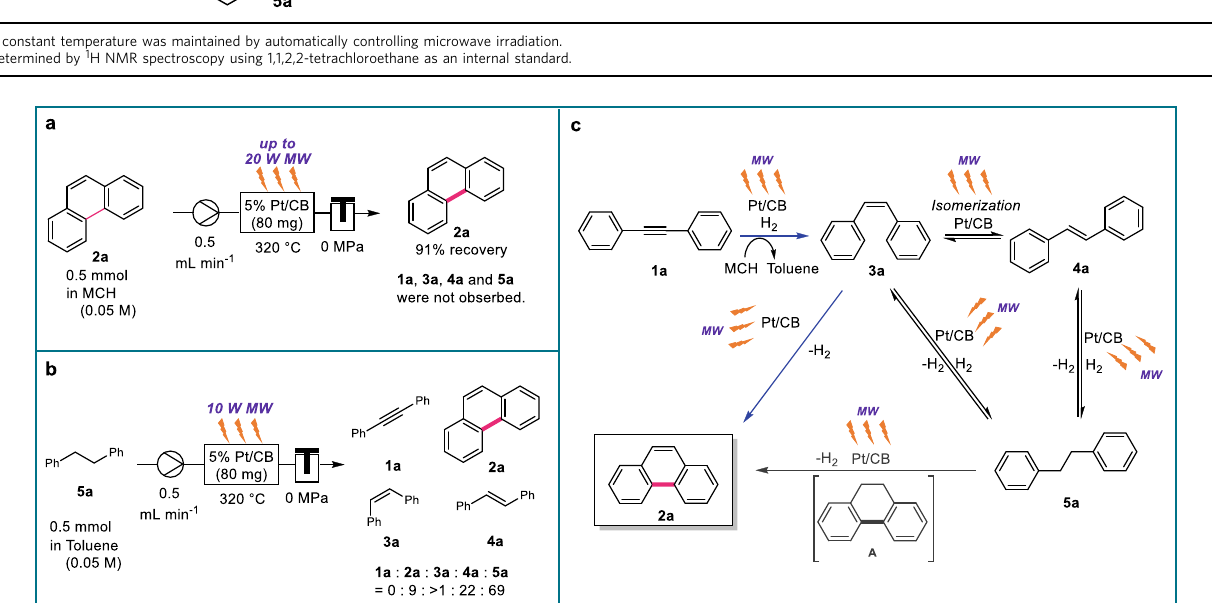
Fig. 5 Control experiments and proposed reaction pathways. a The stability of 2a under MW-assisted C – C bond formation reaction conditions. b MW- assisted C – C bond formation reaction using 5a as a starting material. c Proposed reaction